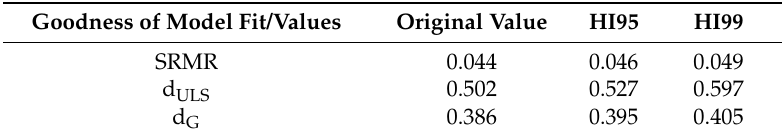
Table 4. Goodness of model